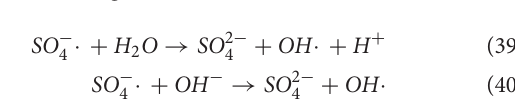
intermediates (see Figure 2